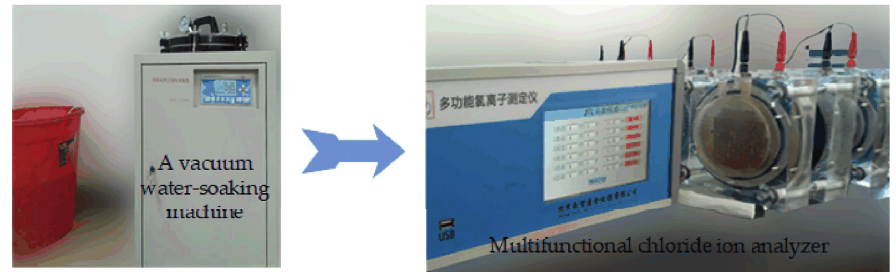
Figure 3: Rapid chloride permeability test of cement concrete in this